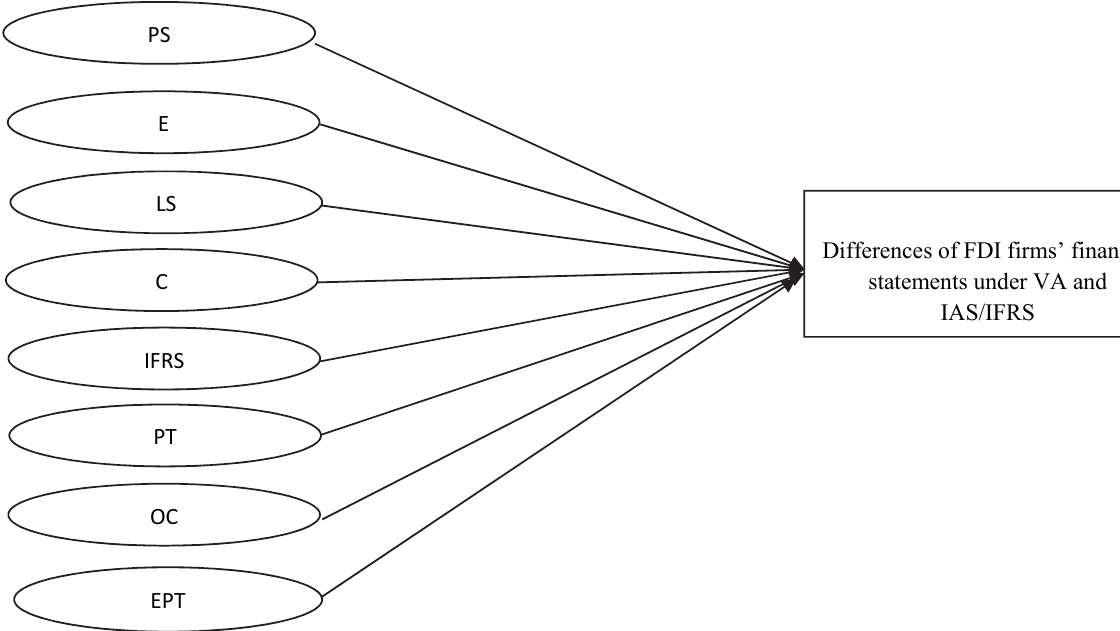
Fig. 1. Research Model of Differences of FDI firms’ Financial Statements Under VA and IAS/IFRS